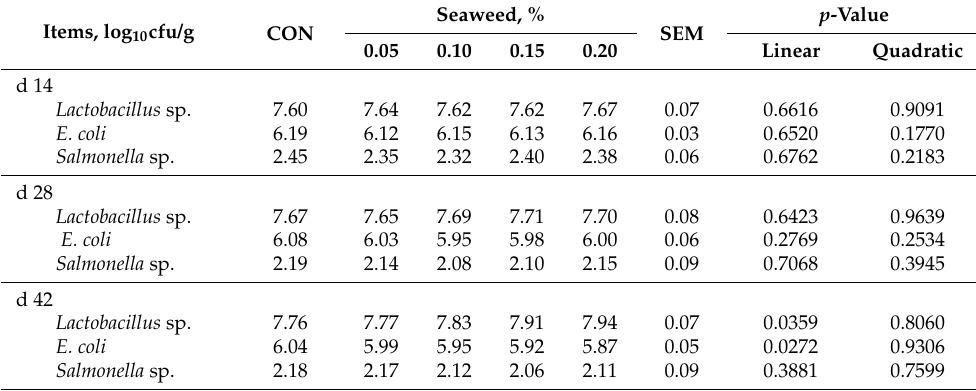
Table 6. The effect of red seaweed supplementation on fecal microbial in broilers 1 . Items, log 10 cfu/g